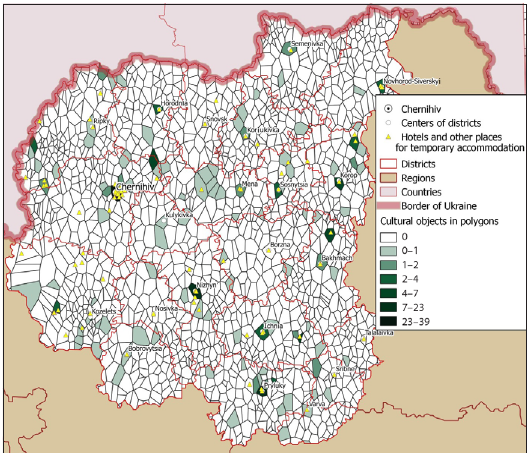
Figure 7. A Voronoi diagram of historical and cultural objects of Chernihiv region with loci around cities, urban settlements and villages